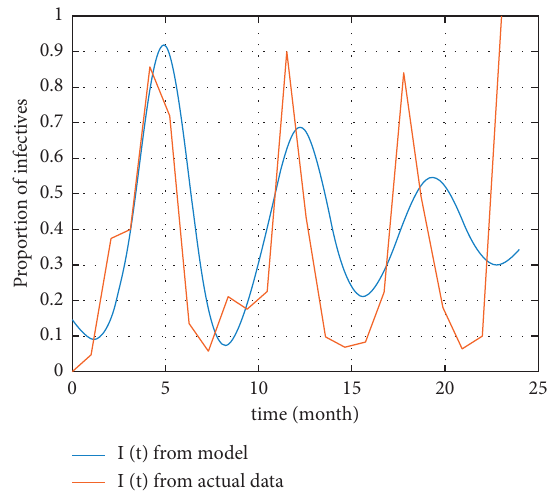
Figure 7: Proportion of infective curves from normalized data and the model. Table 6: Te relative error between the normalized data and the model